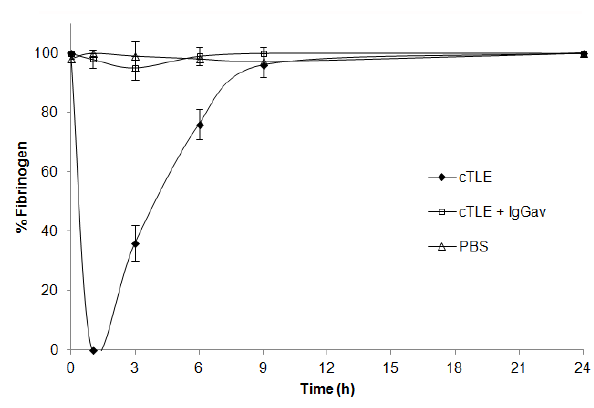
per microgram av per av Figure 4. Neutralization of in vivo fibrinogen consumption of cTLE by IgG . Results are presented av as mean ± S.D. (n = 4). cTLE: crotalic thrombin-like